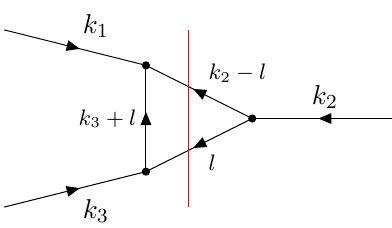
Figure 6 . Cross diagram as a flat space three point function with k 1 = u 1 − u ζ , k 2 = u ζ , k 3 = − u 1 and l = X . The red line corresponds to the unitarity cut in the k 2